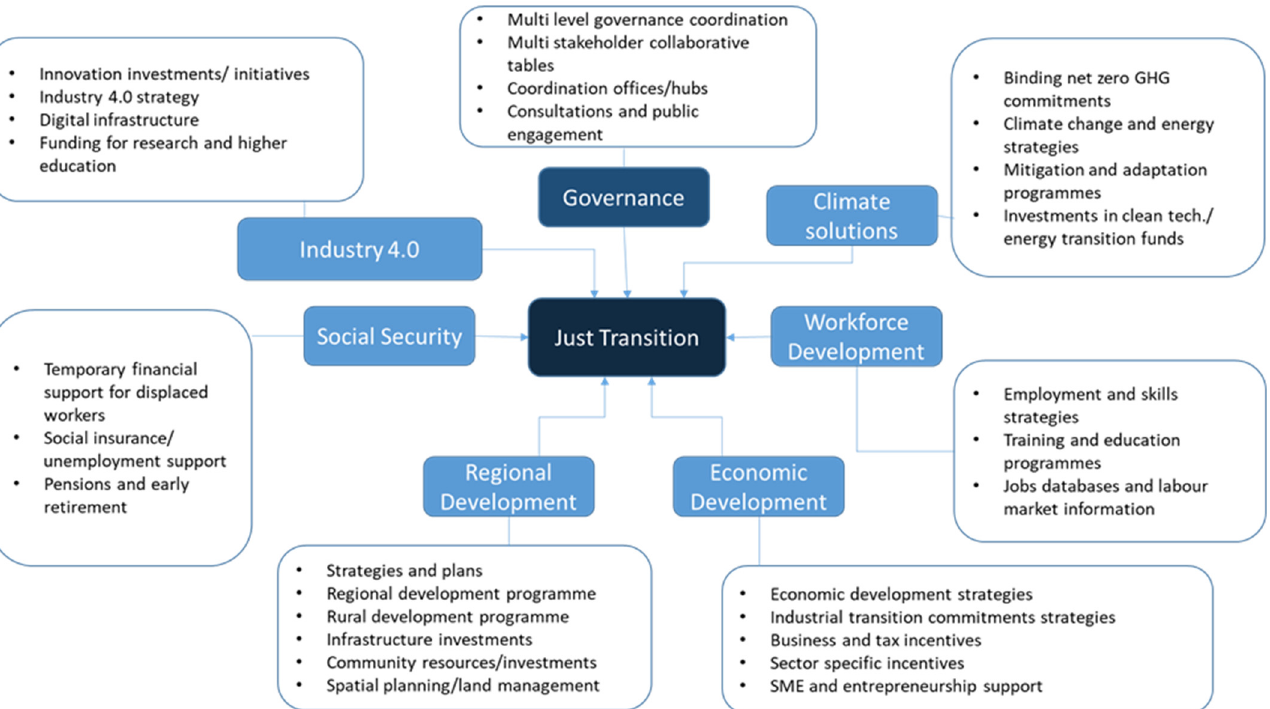
Figure 1. Just transition policies: Conceptual framework. Source: Authors’ own elaboration based on a thematic scoping review.